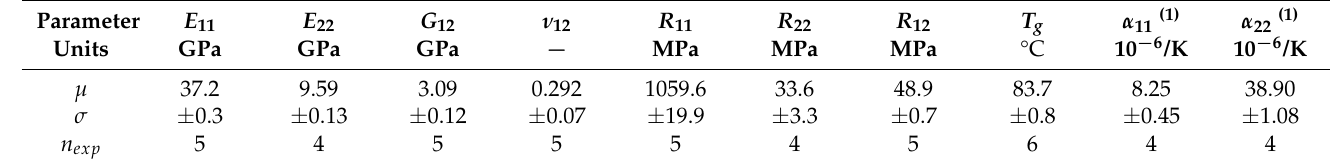
Table 1. Tensile material properties of glass fiber-reinforced composite material.